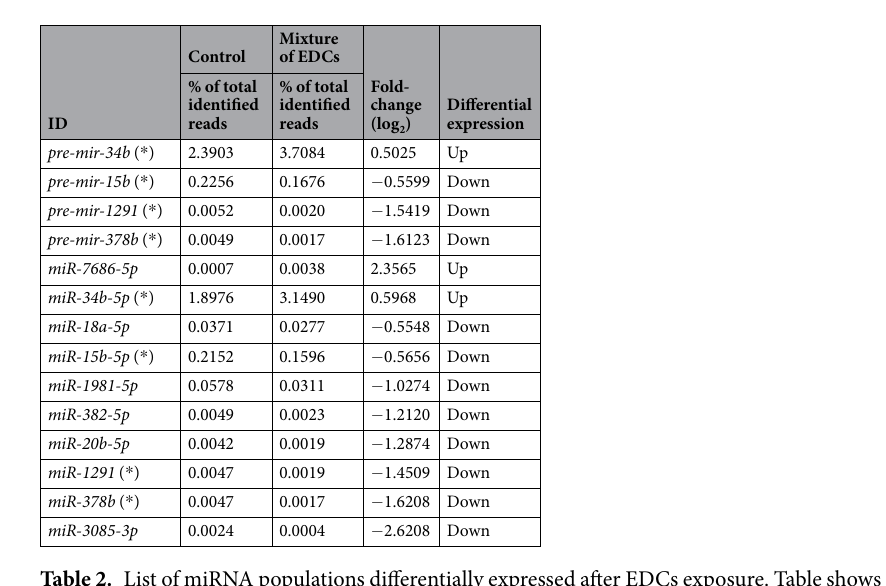
miRNAs precursors and 761 canonical mature miRNAs in samples of ECDs exposed mice (Table 1). Overall, the data showed that 0.75% of pre-miRNAs and 1.31% of canonical miRNAs (ten mature miRNAs) were differentially expressed in control and exposed mice (Table 1). These results suggested that small changes in the miRNome could induce alterations in the phenotypes of testes due to a chronic exposure to the mixture of EDCs. Among the differentially expressed miRNAs in control and exposed mice, precursor and mature forms of miR-34b-5p were up-regulated in EDC-exposed animals (Table 2). miR-34b-5p is involved in the regulation of genes relevant for cell cycle control, apoptosis, and infertility 23, 24 . Thus, it could explain the increased cell death observed in the testes of mice exposed to the EDCs mixture. As for other miRNAs, the most up-regulated was miR-7686-5p , which has no validated mRNA targets, and eight others were down-regulated (Table 2). Some miRNAs are expressed in a polycistronic-like form, which means that they are derived from a single loci and grouped in families and clusters 25, 26 . An important miRNA family involved in testis development and phys- iology is miR-17 , which is included in the miR-17-92 cluster with two identified paralogs: the miR-106a~363 and mir-106b-25 clusters. When we searched in the sncRNA-Seq data for any member of this miR-17 family that was differentially expressed in testes after exposure to the mixture of EDCs, we only identified two down-regulated miRNAs: miR-18a-5p and miR-20b-5p . For the other members of the family, we did not find differences between control and exposed mice (see Supplementary Fig. S2). This result suggested that, while they originated from the same precursor, post-transcriptional regulatory events could explain the differences of expression in control and exposed mice. Afterwards, we validated our data via RT-qPCR with five different miRNAs: three differentially expressed and two unchanged. We selected miR-34b-5p since its precursor and mature form were up-regulated and it had been implicated in apoptosis, a process that was seen to increase after exposure to the mixture of EDCs. The two others were miR-15b-5p and miR-18a-5 , miRNAs that had been implicated in spermatogenesis and sperm function 27, 28 and whose precursors and mature forms were down-regulated. We also selected miR-7a-1-3p and miR-99b-5p as controls, as their levels did not vary in control and exposed mice. The results of RT-qPCR showed that